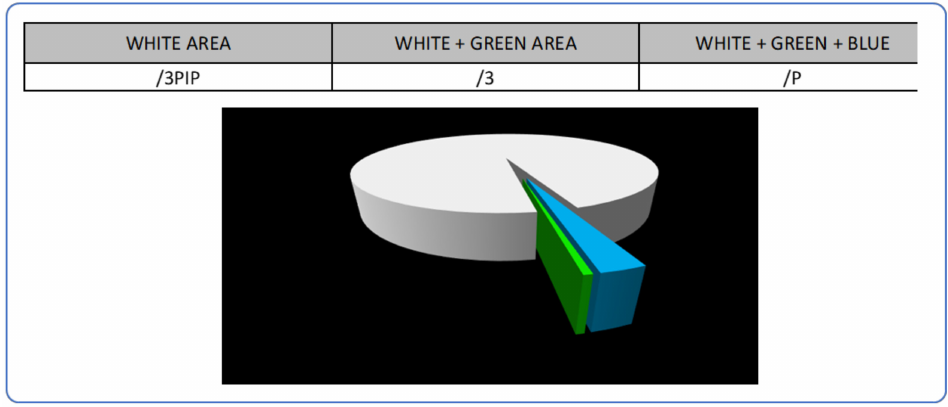
Figure 13. Fuel consumption % graph.